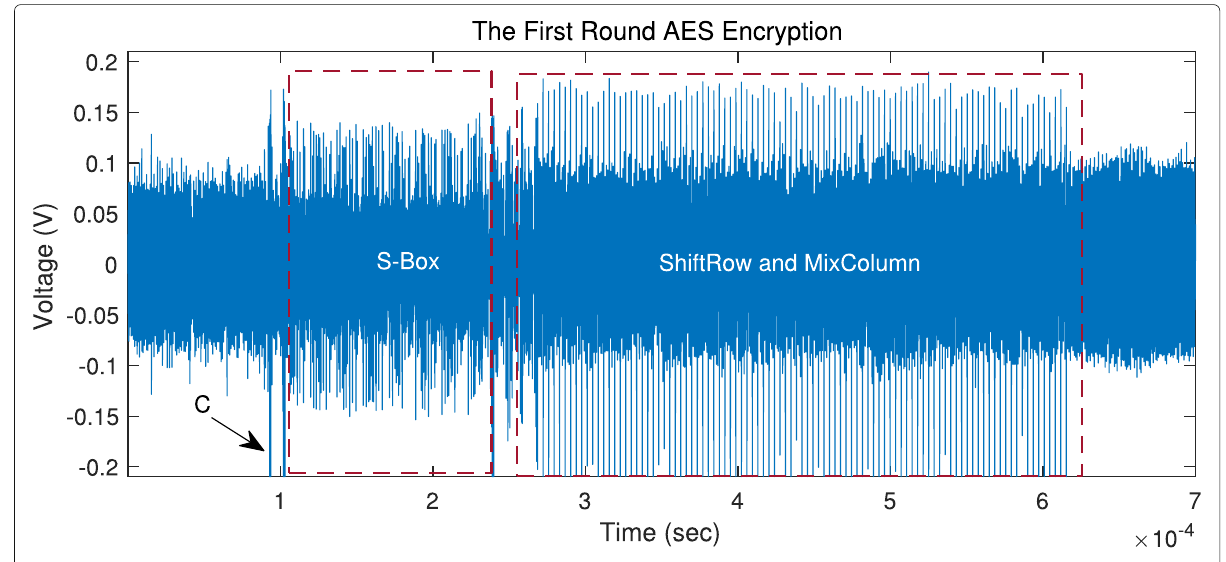
are strongly correlated (Pearson Correlation Coefficient, PCC > 0 . 70 ). Third, for all traces we search the pattern by fixing one trace and sliding the others within a small range to find the position at which the pattern hold the maxi- mum PCC with the pattern in the fixed trace. We exclude